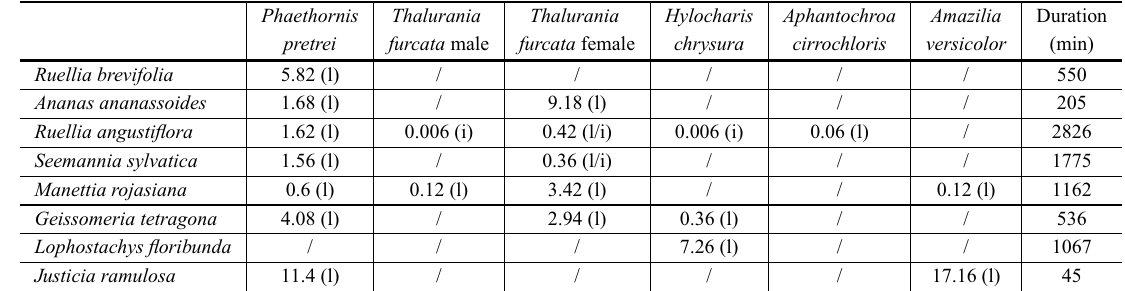
Frequency of hummingbird visitation to the ornithophilous species (number of visits/number of observed flowers/hour) during 8166 min of observation in two habitats (Riparian and semi deciduous forests) of Serra da Bodoquena. (l = legitimate visitation, i = illegitimate